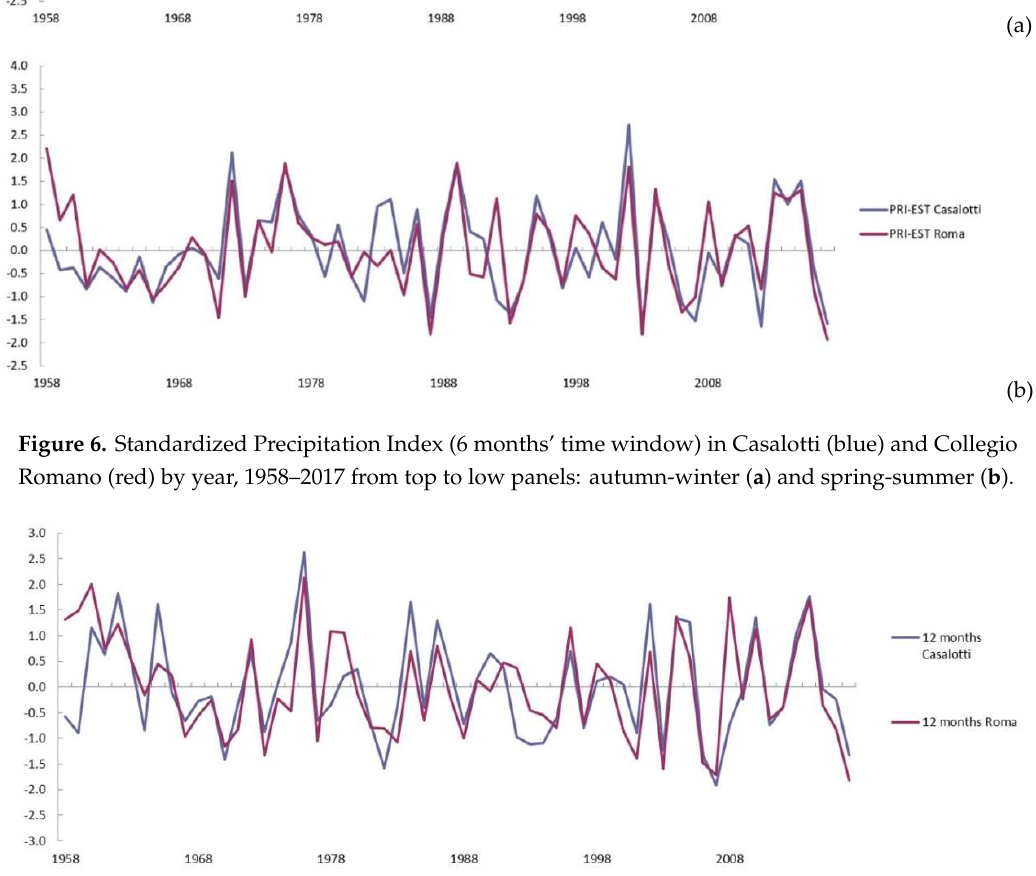
Figure 7. Standardized Precipitation Index (12 months’ time window) in Casalotti (blue) and Collegio Romano (red) by year, 1958–2017.